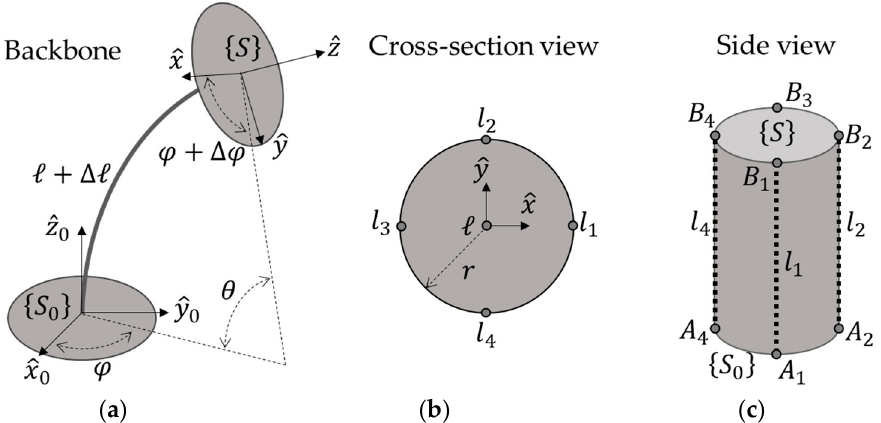
Figure 3. A kinematic scheme of the LARMbot’s torso mechanism: ( a ) Main geometrical and motion parameters of the compliant backbone; ( b ) Cross-section view of a vertebra with actuation tendon routing geometry; ( c ) Side representation of the entire system in a straight configuration with tendons routing points on the lower and upper torso.